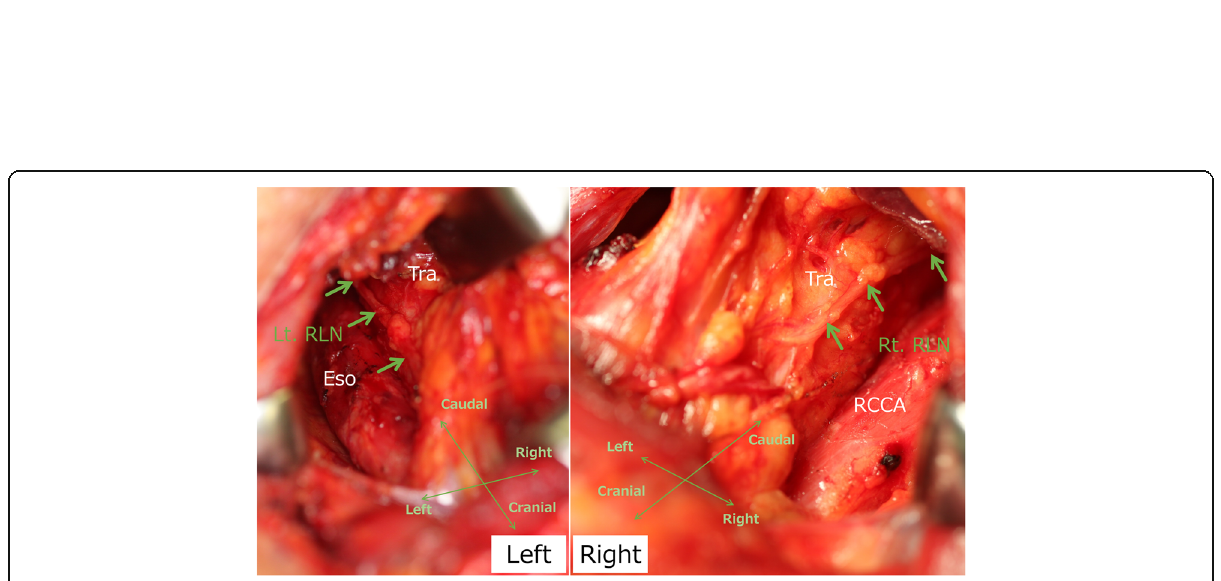
Fig. 3 Intraoperative findings of trans-cervical upper mediastinal lymph node dissection in the preceding cervical procedure. Green arrows indicate the recurrent laryngeal nerves. We were able to identify the bilateral recurrent laryngeal nerves ascending along the trachea and esophagus just like the typical left recurrent laryngeal nerve. Eso, esophagus; Lt./Rt. RLN, left/right recurrent laryngeal nerve; Tra,